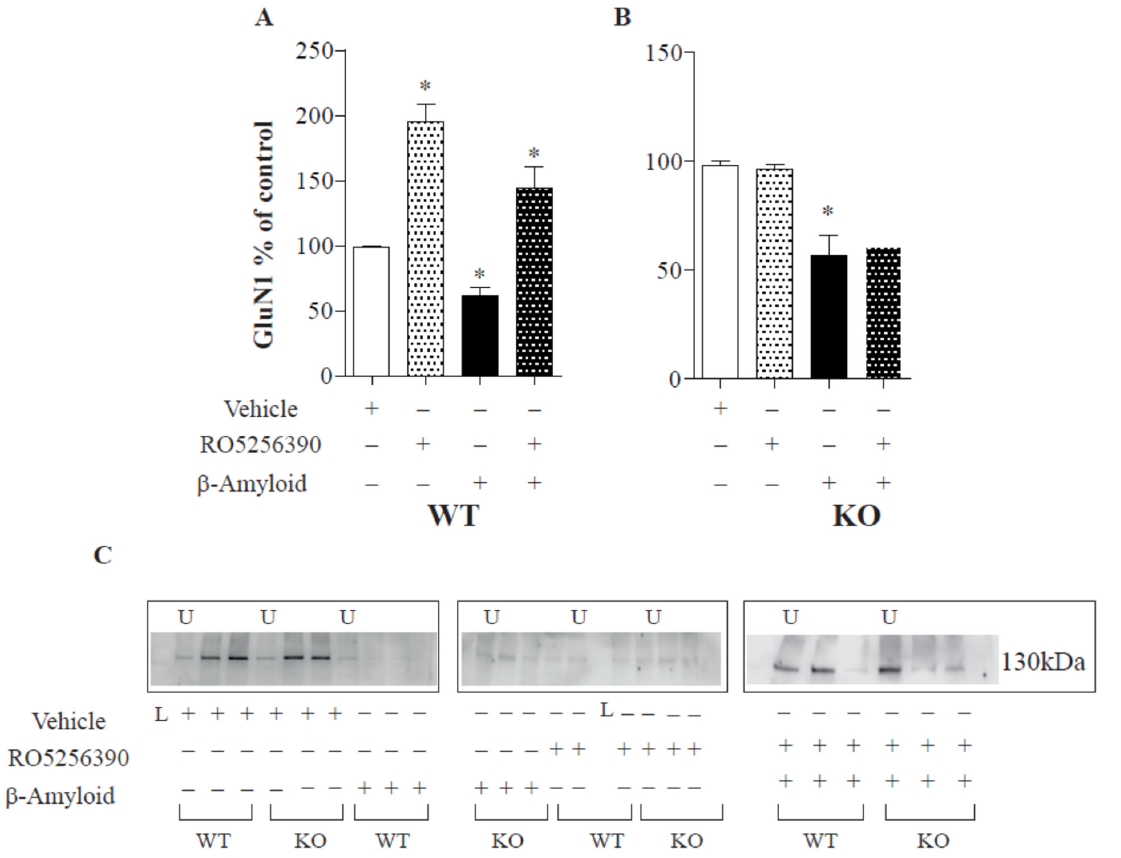
Figure 1. Effect of A β and RO5256390 on NR1 receptors in vitro. A β application in cell medium reduces NR1 surface expression, while TAAR1 activation (induced by RO5256390 agonism) is able to counteract A β effects in control cells ( A ) but not in KO cell cultures ( B ). ( C ) Examples of Western blot images: U = unbound (cells not treated with biotin), L = ladder. Results are representative of six different cell cultures (* p < 0.05).